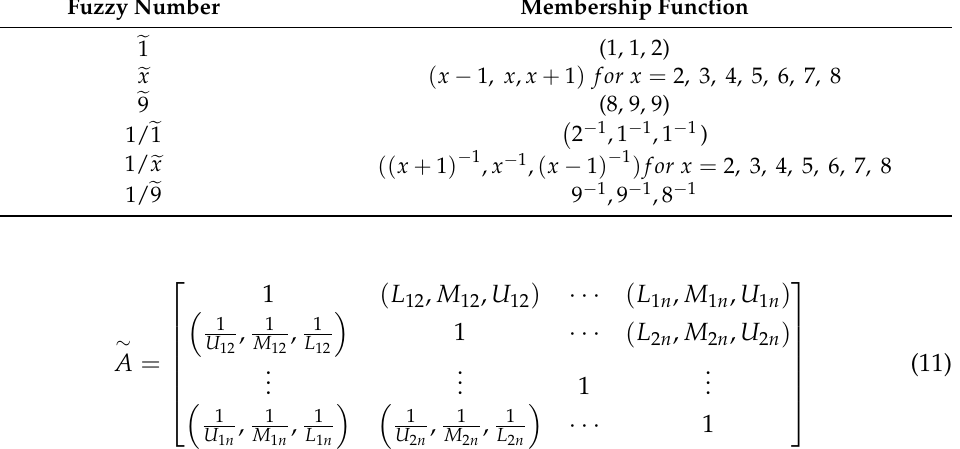
Table 4. Membership function of fuzzy numbers in Bollinger logic. Fuzzy Number Membership